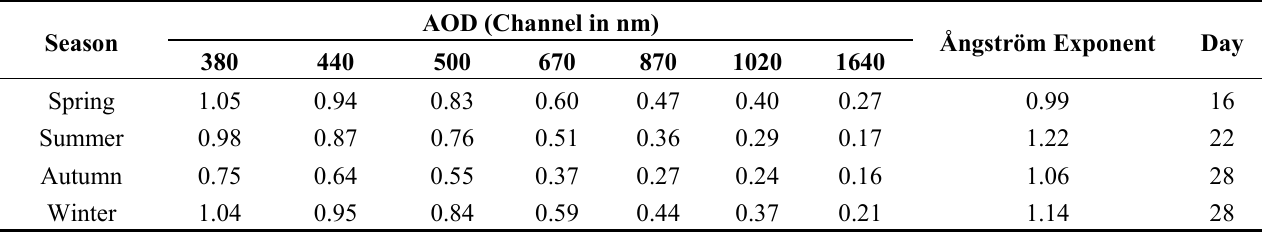
Table 1. Seasonally averaged aerosol optical depths (AOD) of each channel (nm) and Ångström exponent